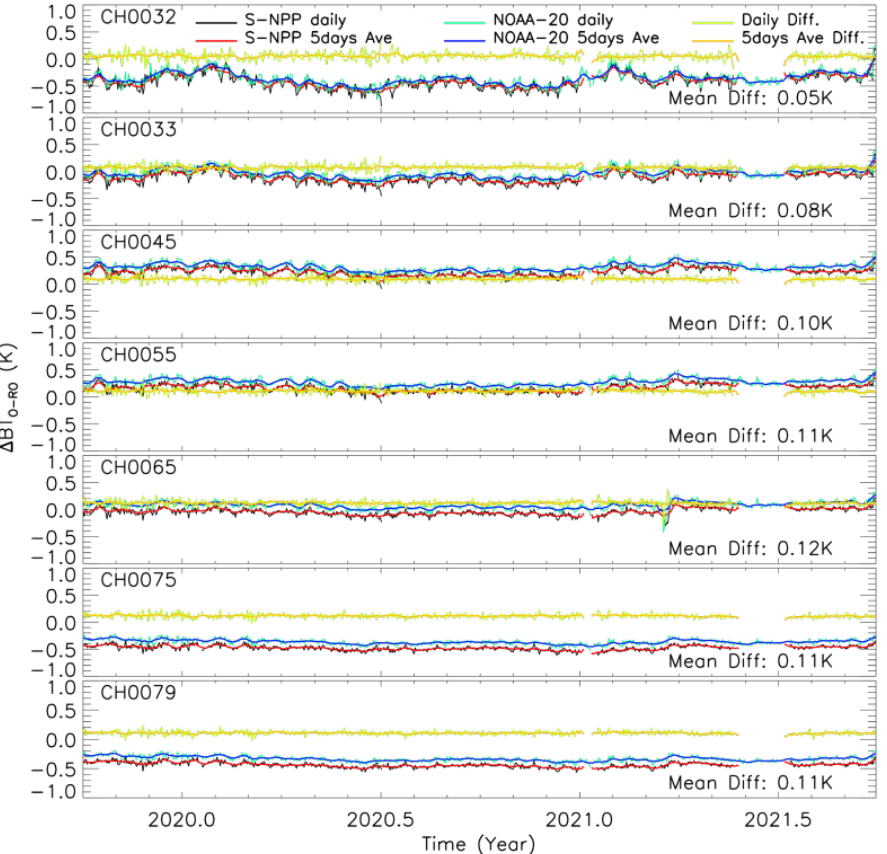
Figure 7. Brightness temperature difference time series for selected CrIS channels in LWIR band between CrIS observations and simulations with COSMIC-2 RO data during the two years from 1 October 2019 to 30 September 2021. The inter-satellite differences between NOAA-20 and S-NPP are also included. UCAR implemented an update in the WETPf2 1DVAR algorithm around 23 March 2021, which caused a small jump in the BT difference time series. On 28 September 2021, ECMWF forecasts replaced GFS forecasts as the a priori. Among these seven channels, the upper two channels (32 and 33) and the bottom two channels (75 and 79) show a negative difference (can be large as − 0.5 K), which means that observed radiances are less than radiances simulated using COSMIC-2 data. However, the reasons contributing to the negative difference are different. For channels 32 and 33, the negative difference is mainly due to the lack of an accurate temperature profile at the top of the atmosphere. In contrast, for channels 75 and 79, it is due to the default CO 2 amount used in the CRTM simulation. The default CO 2 amount is about 384 parts per million volume (ppmv) in